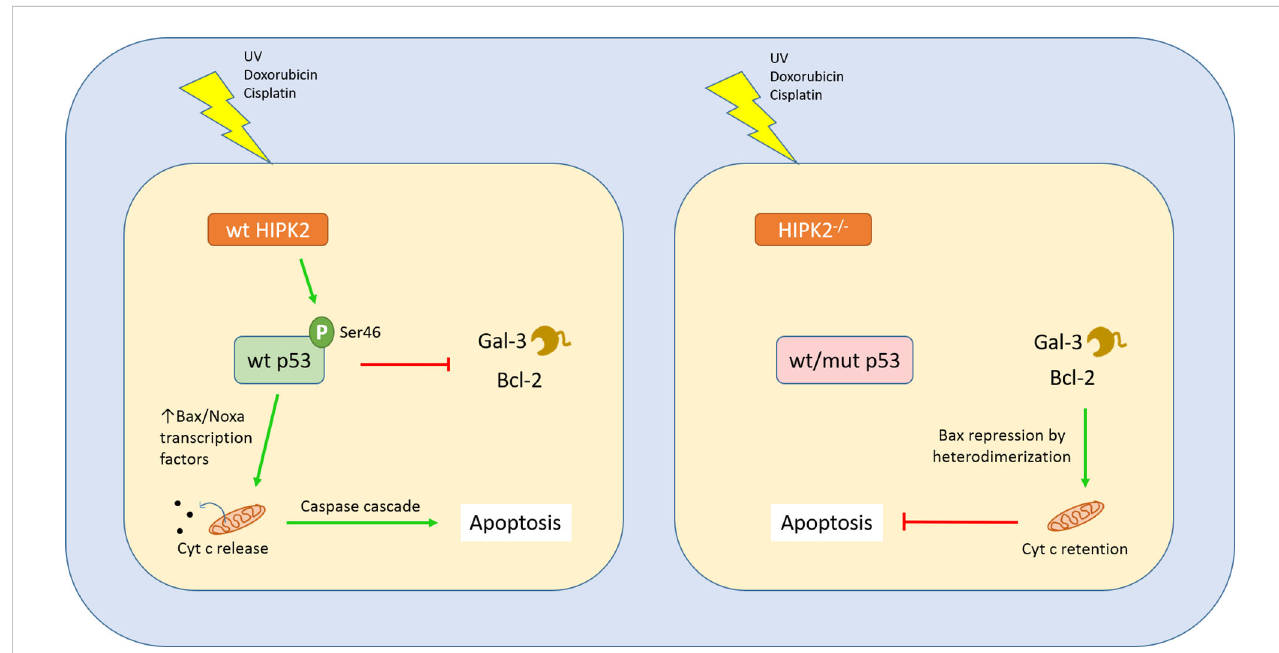
FIGURE 2 Interplay between Gal-3 and the p53 apoptotic pathway. The p53 is a master regulator of cell cycle and apoptosis, induced by cellular exposure to a variety of genotoxic damage agents or stress signals. In order to initiate apoptosis, p53 switches to its activated form through phosphorylation at serine 46 by the Ser/Thr kinase HIPK2. This modi fi cation confers af fi nity for promoters of genes involved in the apoptotic cascade. The downstream steps have been well characterized and can be found in other works, leading to mitochondrial disintegration and release of cytochrome C, eventually triggering apoptosis through activation of the caspase pathway. When wild type p53 is activated by Ser46 phosphorylation, it binds to the promoter of Gal-3, negatively regulating its transcription. On the other hand, when HIPK2 is absent or TP53 bears mutations leading to a dysfunctional p53, Gal-3 is upregulated in response to stress signals (53). Gal-3 acts similarly to the apoptosis-inhibiting family of Bcl2 proteins, through a conserved peptide motif, preserving mitochondrial integrity and conferring cellular resistance to apoptotic cues